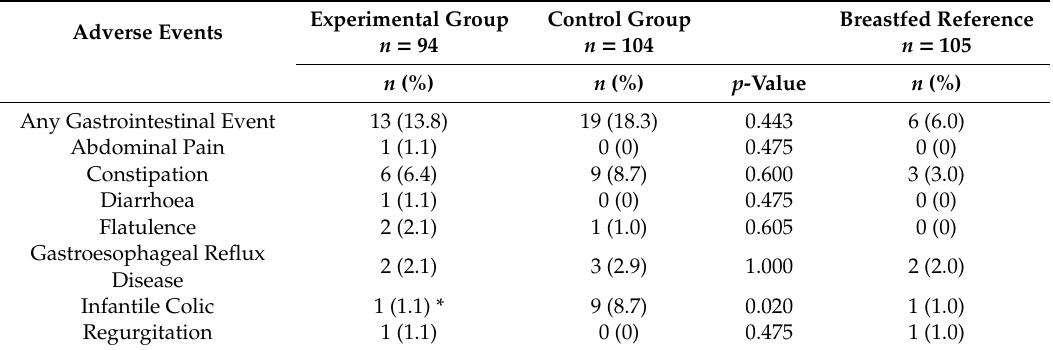
Table 2. Gastrointestinal disorders reported by investigators as Adverse Events (AEs) in the study population